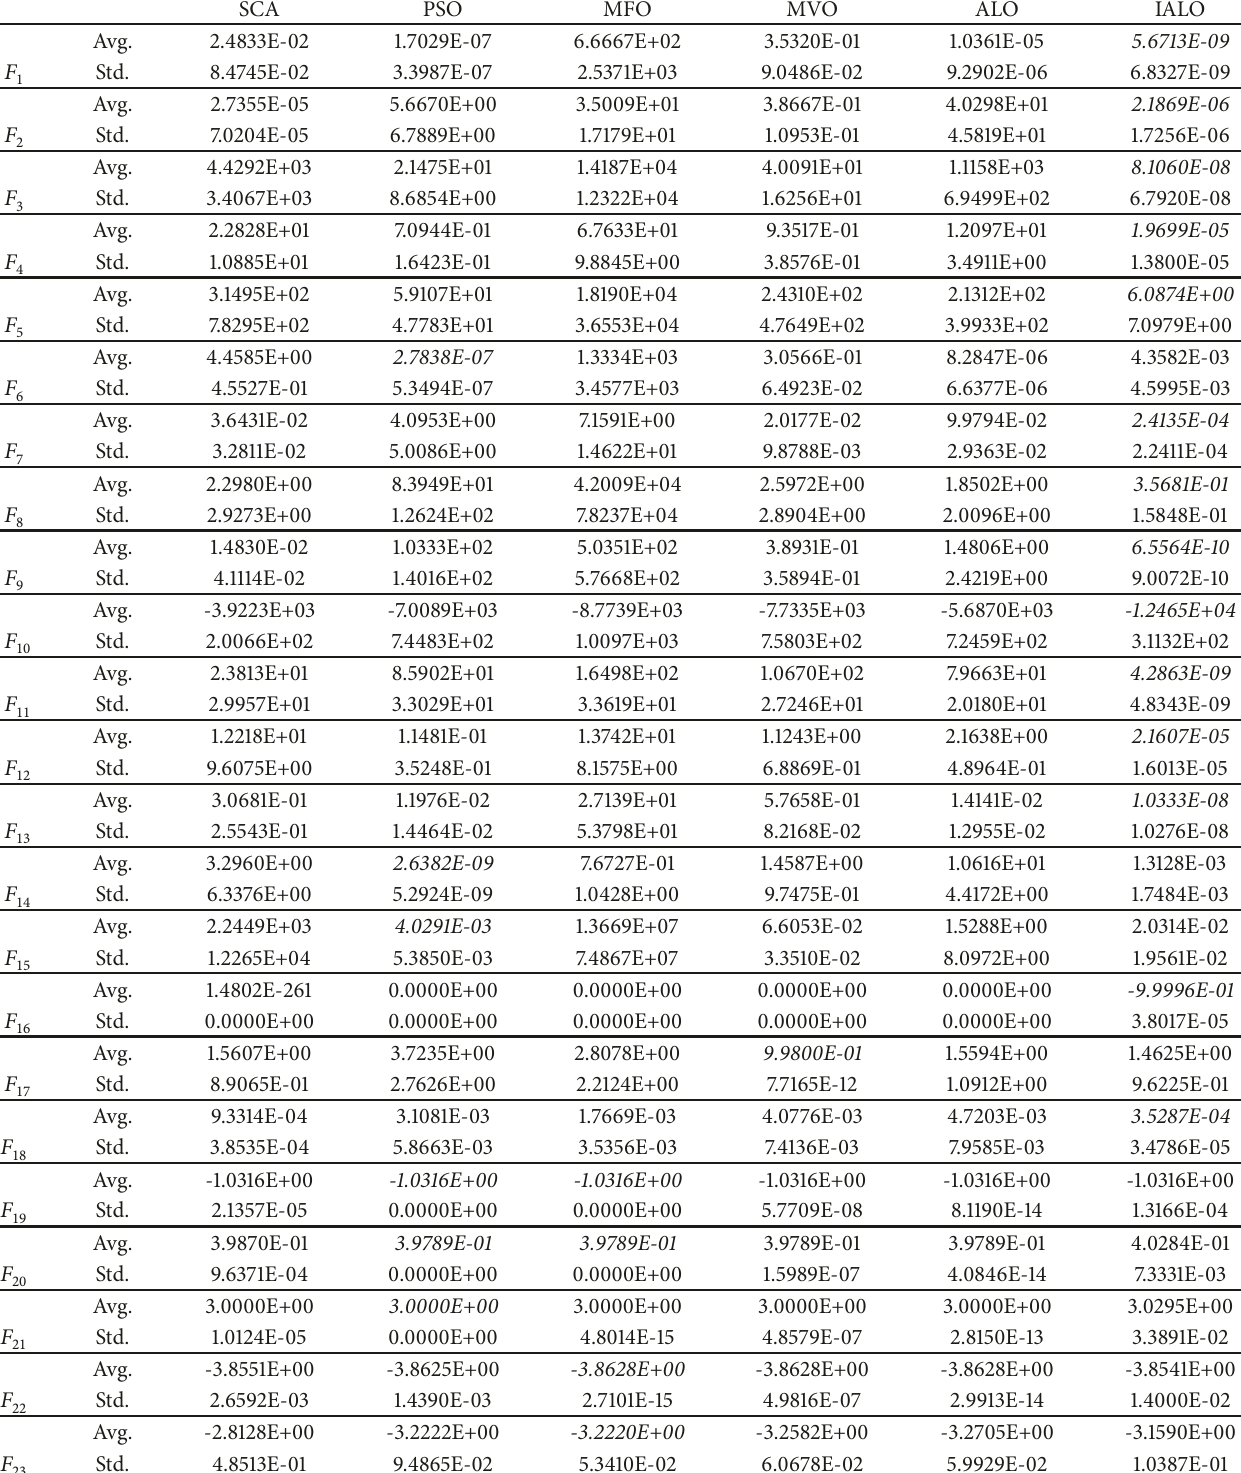
Table 2: The average value and the standard derivation of benchmark functions 𝐹 1 (𝑥) − 𝐹 23 (𝑥) . SCA PSO MFO MVO ALO IALO